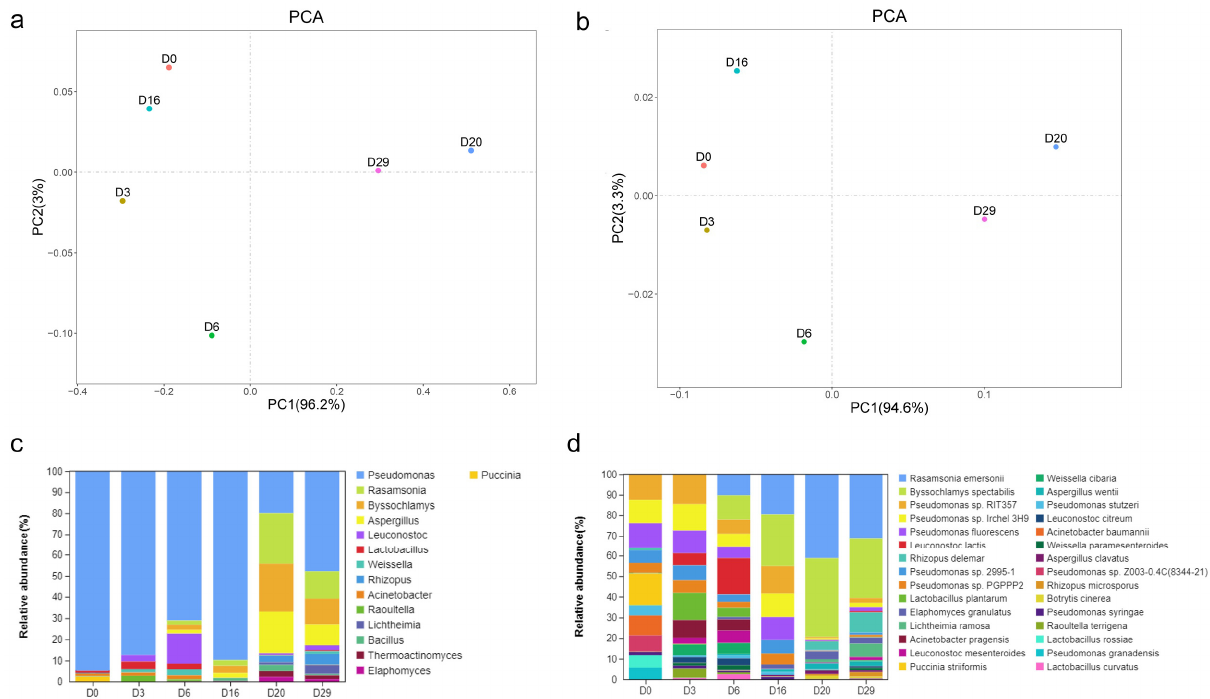
Figure 3. Sankey network diagram of fungal community composition in Daqu (based on amplicon sequencing).